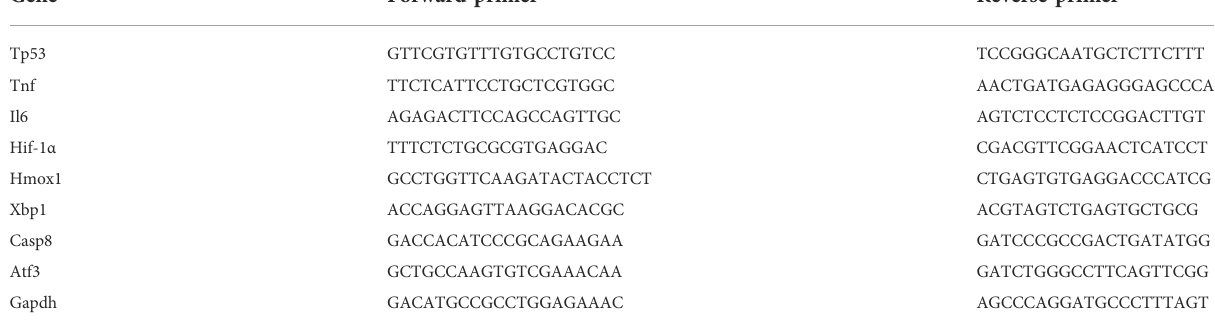
TABLE 2 Primers for real-time polymerase chain